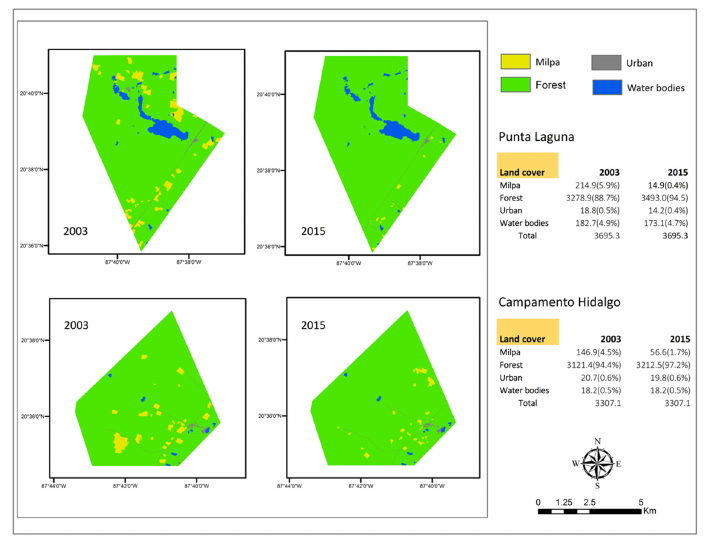
Figure 4. Land-cover change in the focal areas surrounding the communities inside (PL) and outside the PA (CH), before (2003) and after (2015) its establishment. Surface area (ha) and percentages (in parenthesis) of cover classes are shown for each area.